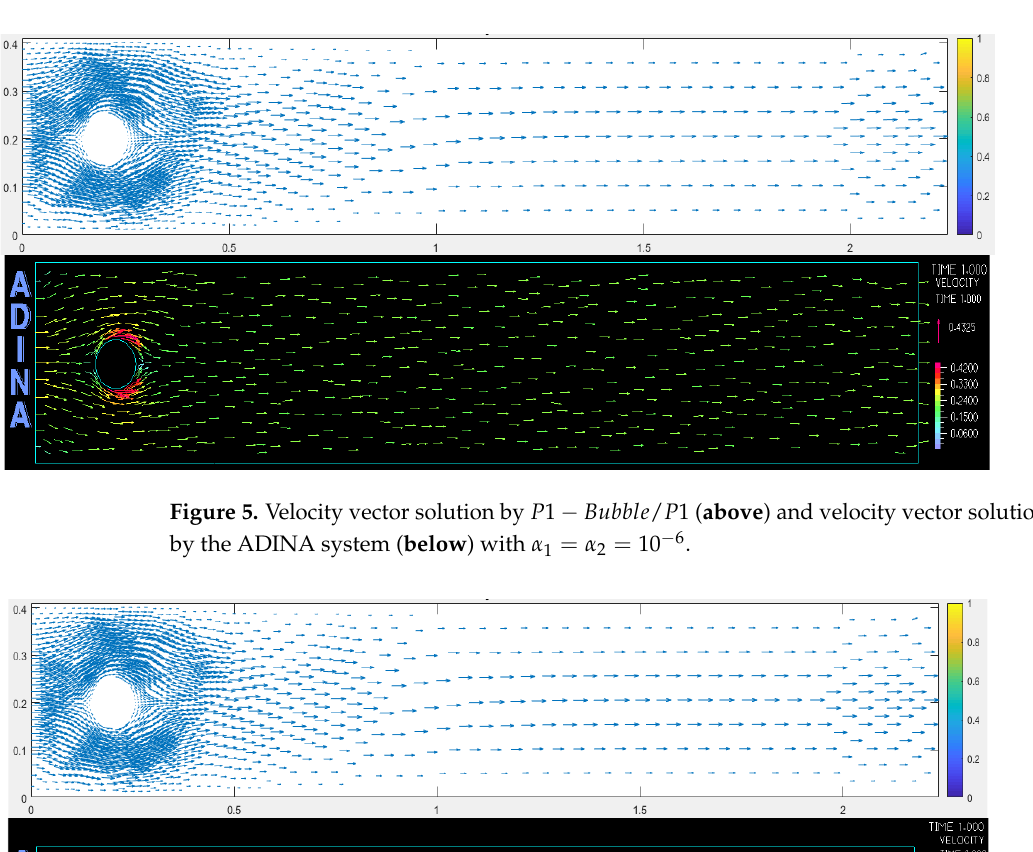
, , −4 𝛼𝛼 1 = 10 −4 𝛼𝛼 1 = 10